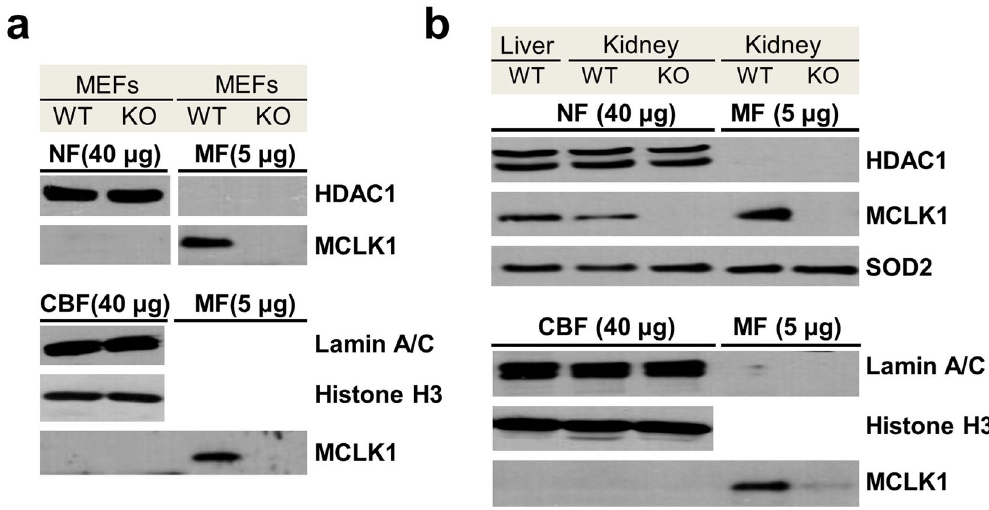
Figure 7. Detection of MCLK1 in protein fractions. Western blot analysis of nuclear protein extracts prepared from mouse embryonic fibroblasts (MEFs) ( a ) and Western blot analysis of nuclear protein fractions from mouse tissues ( b ). Mclk1 KO cells were generated as previously published 34 and the KO tissue samples were obtained from ago Mclk1 KO mice described in ref. 47. They were used to further confirm band identity. The wild-type controls are Mclk1 floxed MEFs or tissues without Cre expression. In both panels, 40 µ g proteins per lane were loaded except for the membrane fraction (MF), where 5 µ g were used. HDAC1 was used as a loading control of nuclear soluble fractions (NF). For insoluble (chromatin-bound) nuclear fractions (CBF), lamin A/C and Histone H3 served as markers. The mitochondrial matrix protein SOD2 was used as an additional control to validate the purity of the nuclear protein fractions. ( a ) In MEFs, MCLK1 could only be detected in membrane fractions (MF). ( b ) In mouse tissues, MCKL1 could be detected in both nuclear soluble fractions (NF) and membrane fractions (MF). However, the mitochondrial matrix protein SOD2 could also be detected in both fractions suggesting that the nuclear soluble fraction was contaminated by mitochondria. MCLK1 could not be detected in the chromatin-bound nuclear fraction (CBF). No evidence therefore points to the presence of MCLK1 in the nucleus or an association with chromatin. Uncropped western blot scans with size indications are shown in Supplementary